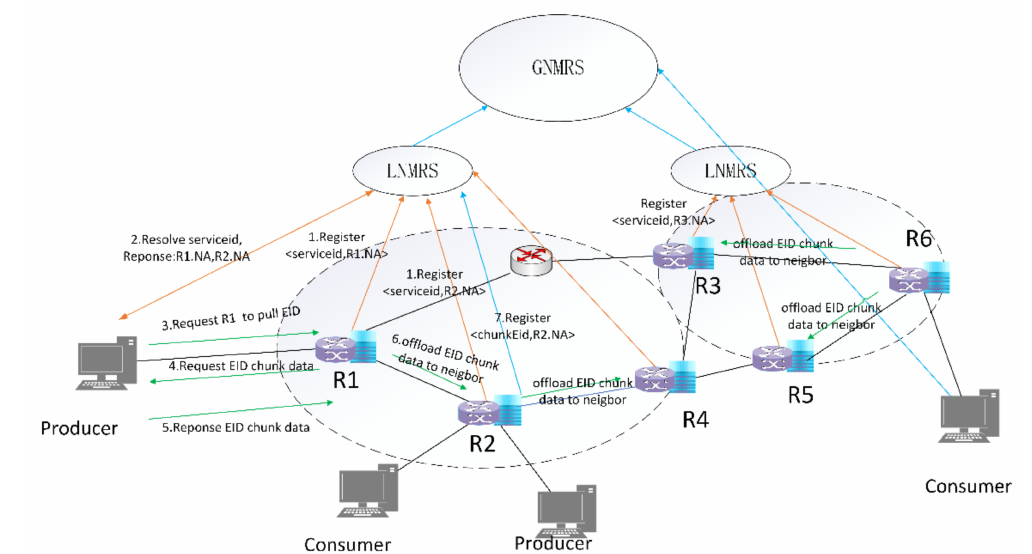
Figure 1. The overview of the chunk storage